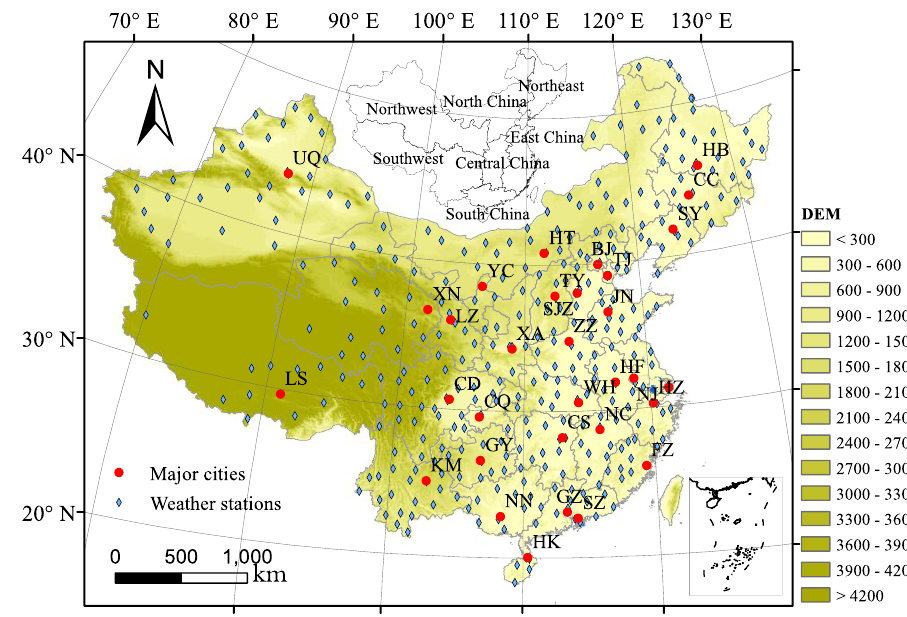
Figure 1. Map showing the topography of China and the location of weather stations and the 32 major cities. These cities are municipalities or provincial capitals, except a special economic zone of Shenzhen. A total of 370 weather stations from the National Weather Service (NWS) record the hourly surface air temperature (SAT). Subplot shows seven geographical divisions in China. Abbreviations: